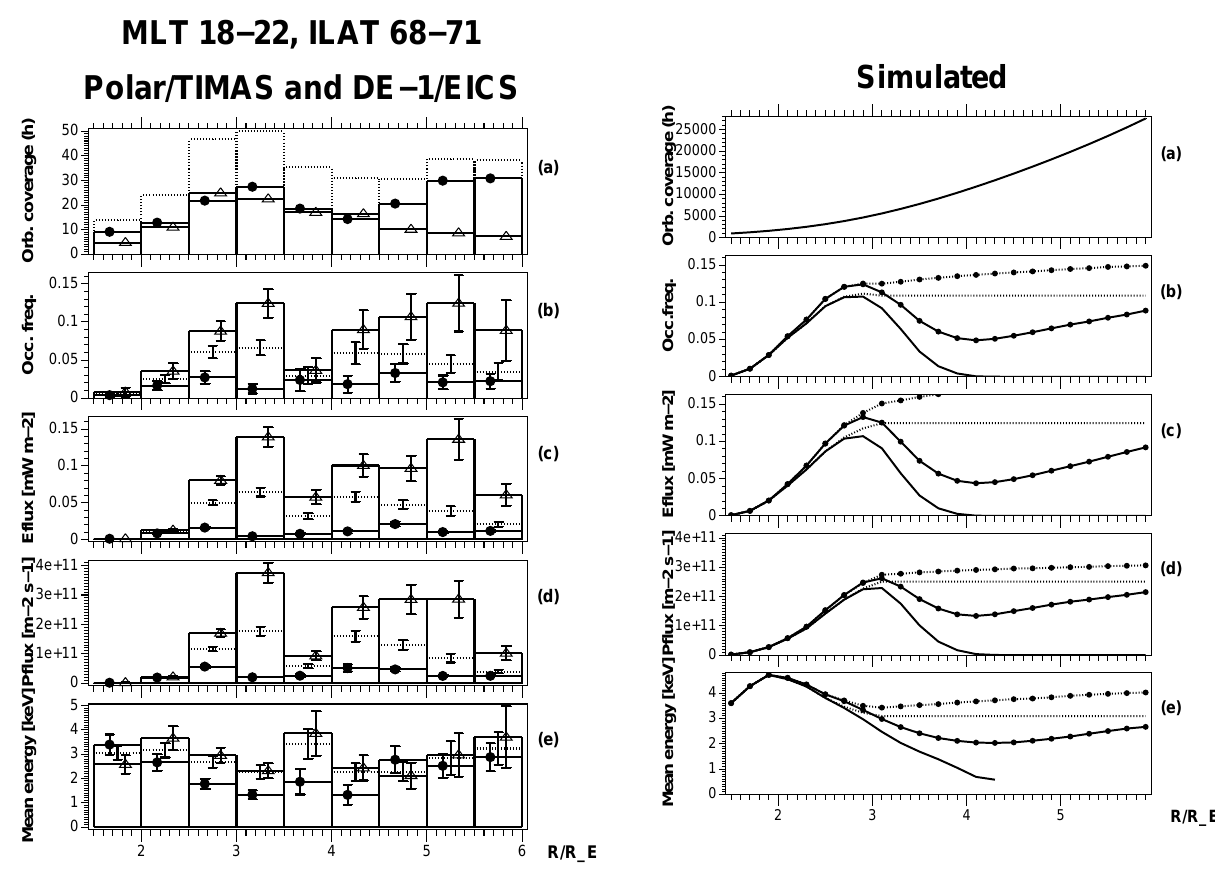
Fig. 10. Left panel: Mean energy and particle fluxes carried by ion beams in the evening MLT sector (18–22) and ILAT range 68–71. (a) Orbital coverage in hours, (b) occurrence frequency of ion beams, (c) average invariant energy flux (“invariant” means the quantity is projected to ionospheric altitude), (d) average invariant particle flux, (e) mean energy (panel c divided by panel d). Right panel: Four simulated examples (see text), solid line corresponds to a closed potential structure and dotted line to an open structure; lines with black circles correspond to cases having additional wave energization (see